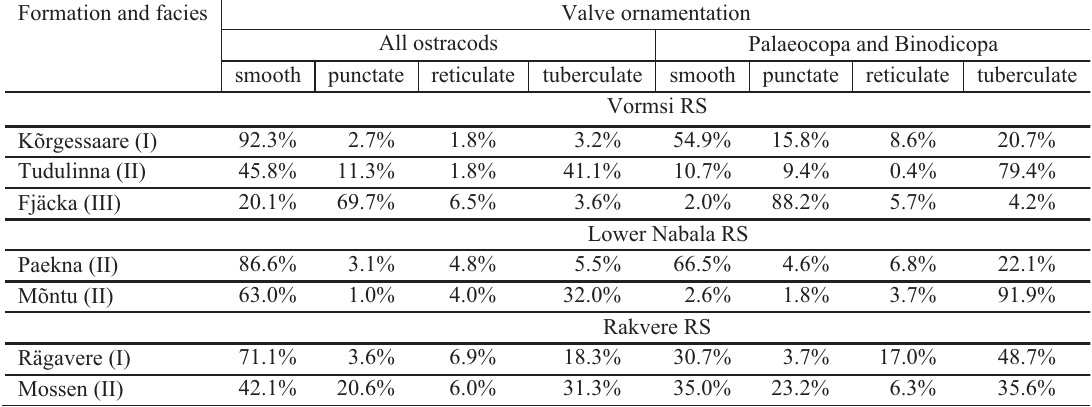
Table 4. Distribution of valve ornamentation in formations (average relative abundance); I – mixed facies, II – mud- supported facies, III – black shale facies